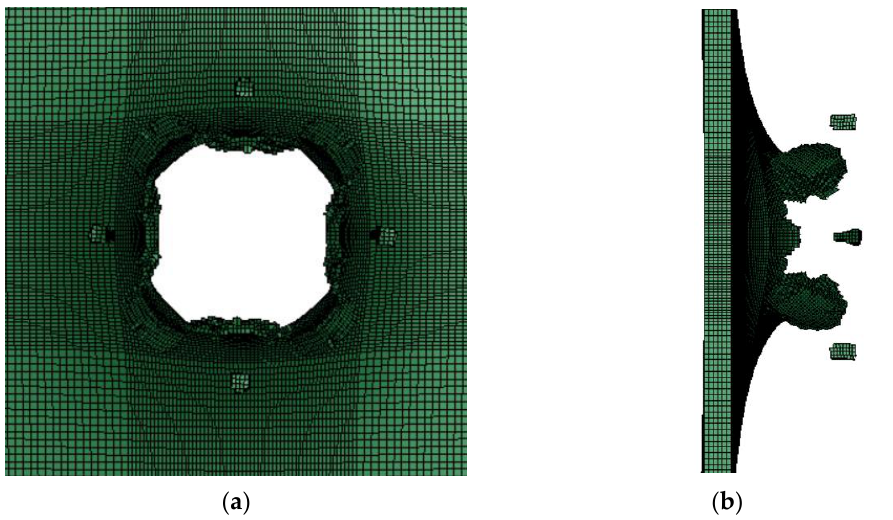
Figure 6. The destruction of the target board in the simulation: ( a ) Back view of target plate; ( b ) side view of the target plate.